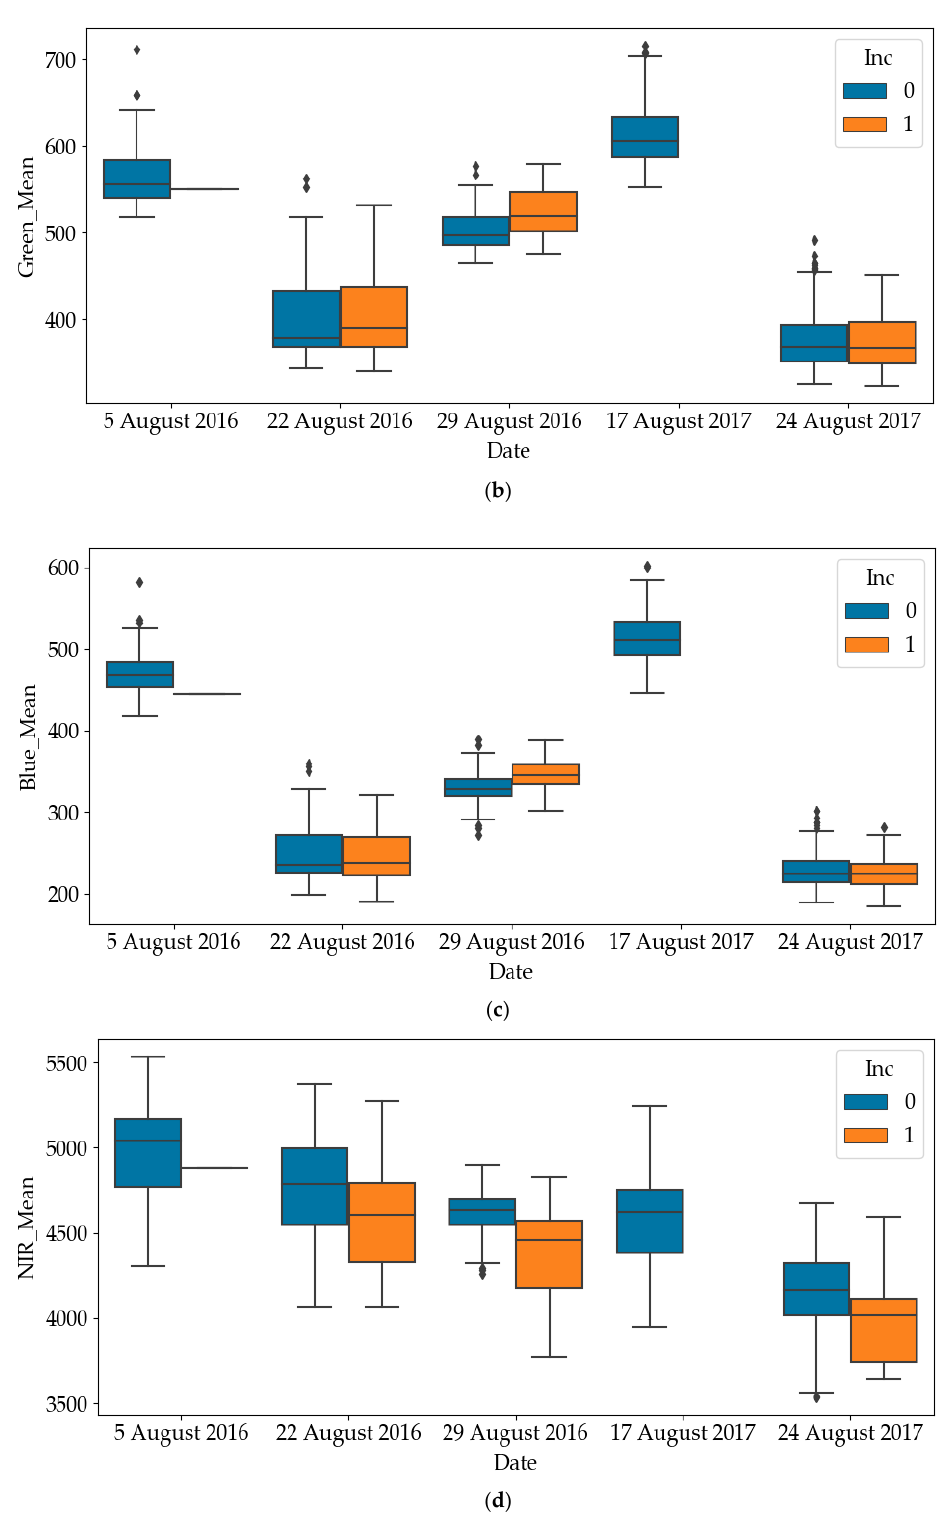
Figure 4. Di ff erences in red, green, blue and near-infrared (NIR) values between healthy and diseased quadrats (Inc = 0: Healthy; Inc = 1: Diseased). ( a ) Di ff erence in red values between healthy and diseased quadrats; ( b ) Di ff erence in green values between healthy and diseased quadrats; ( c ) Di ff erence in blue values between healthy and diseased quadrats; ( d ) Di ff erence in NIR values between healthy and diseased